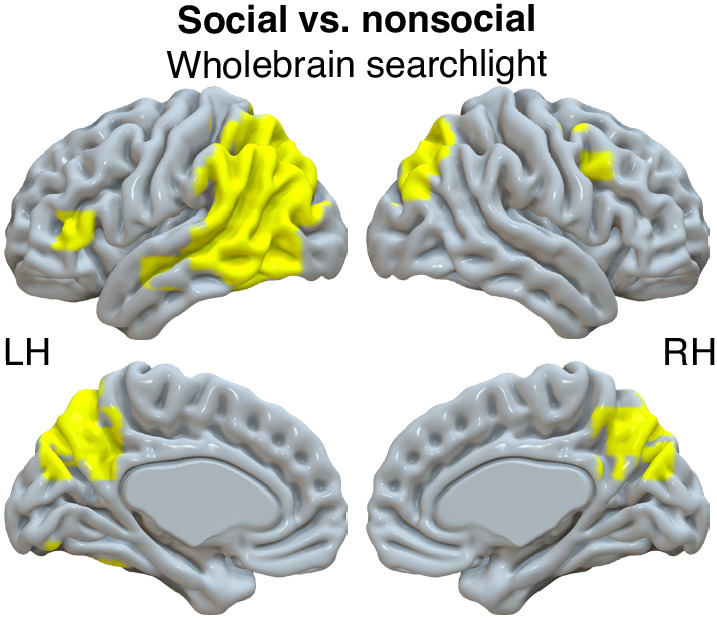
Decoding social versus nonsocial stories at the whole-brain level.The clusters shown are areas of overlap between four whole-brain, searchlight analyses, for the social-versus-nonsocial comparison (endogenous-self versus nonsocial, exogenous-self versus nonsocial, endogenous-other versus nonsocial, exogenous-other versus nonsocial). See Supplementary file 4 for numerical details. Projected onto a 3D canonical brain surface.